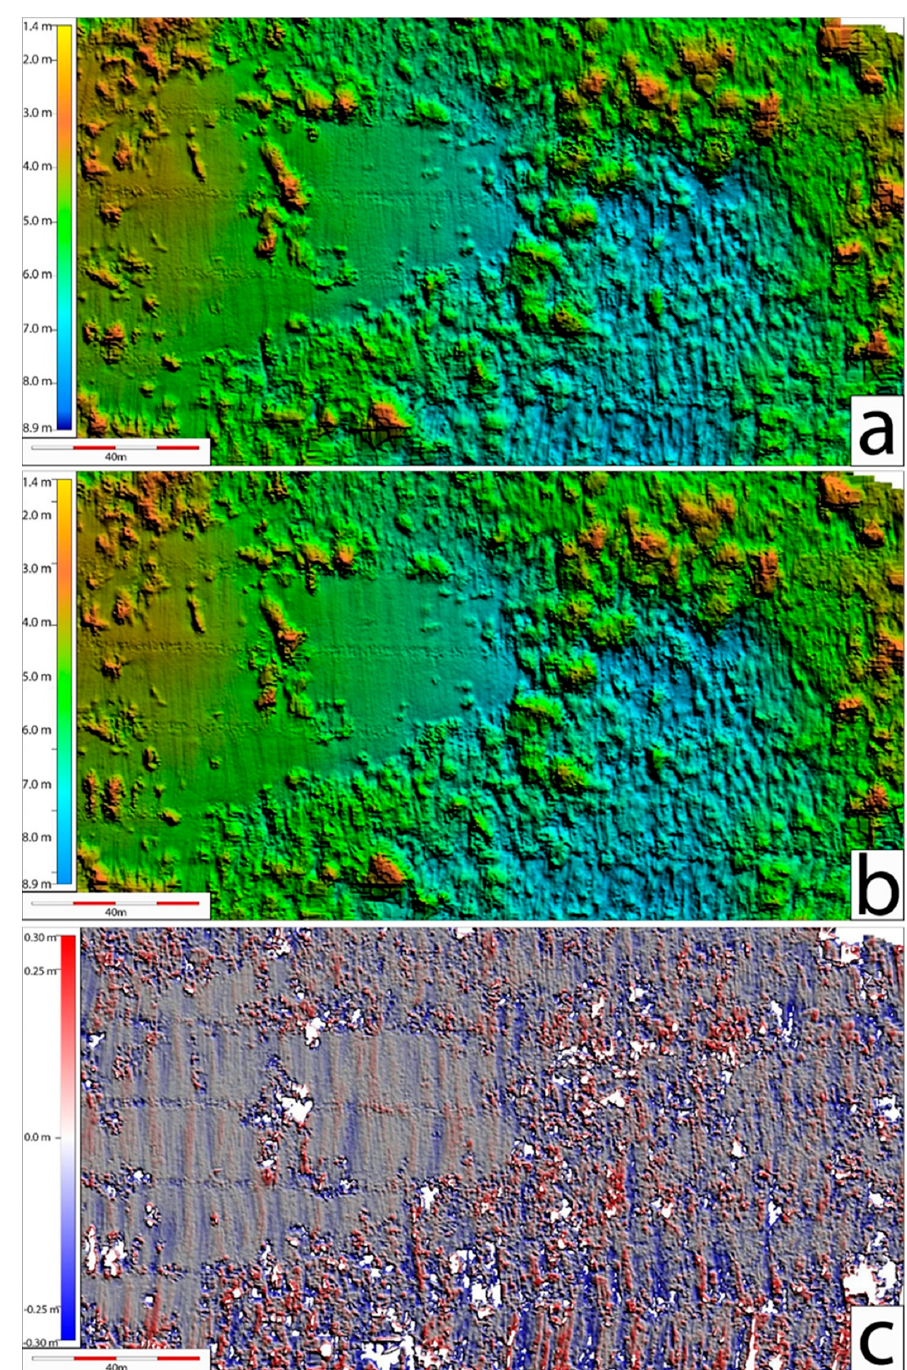
Figure 12. Bathymetric data collected using a Klein Hydrochart 3500 multibeam echosounder onboard of an OpenSWAP vehicle, including: ( a ) a first survey; ( b ) a second acquisition performed next day; and ( c ) the point-to-point di ff erence between the two DTMs. Note that over 95% (colored dots) are within ± 30 cm of di ff erence. Red and blue undulations in c result from short-term seafloor changes, probably due to sand-ripple